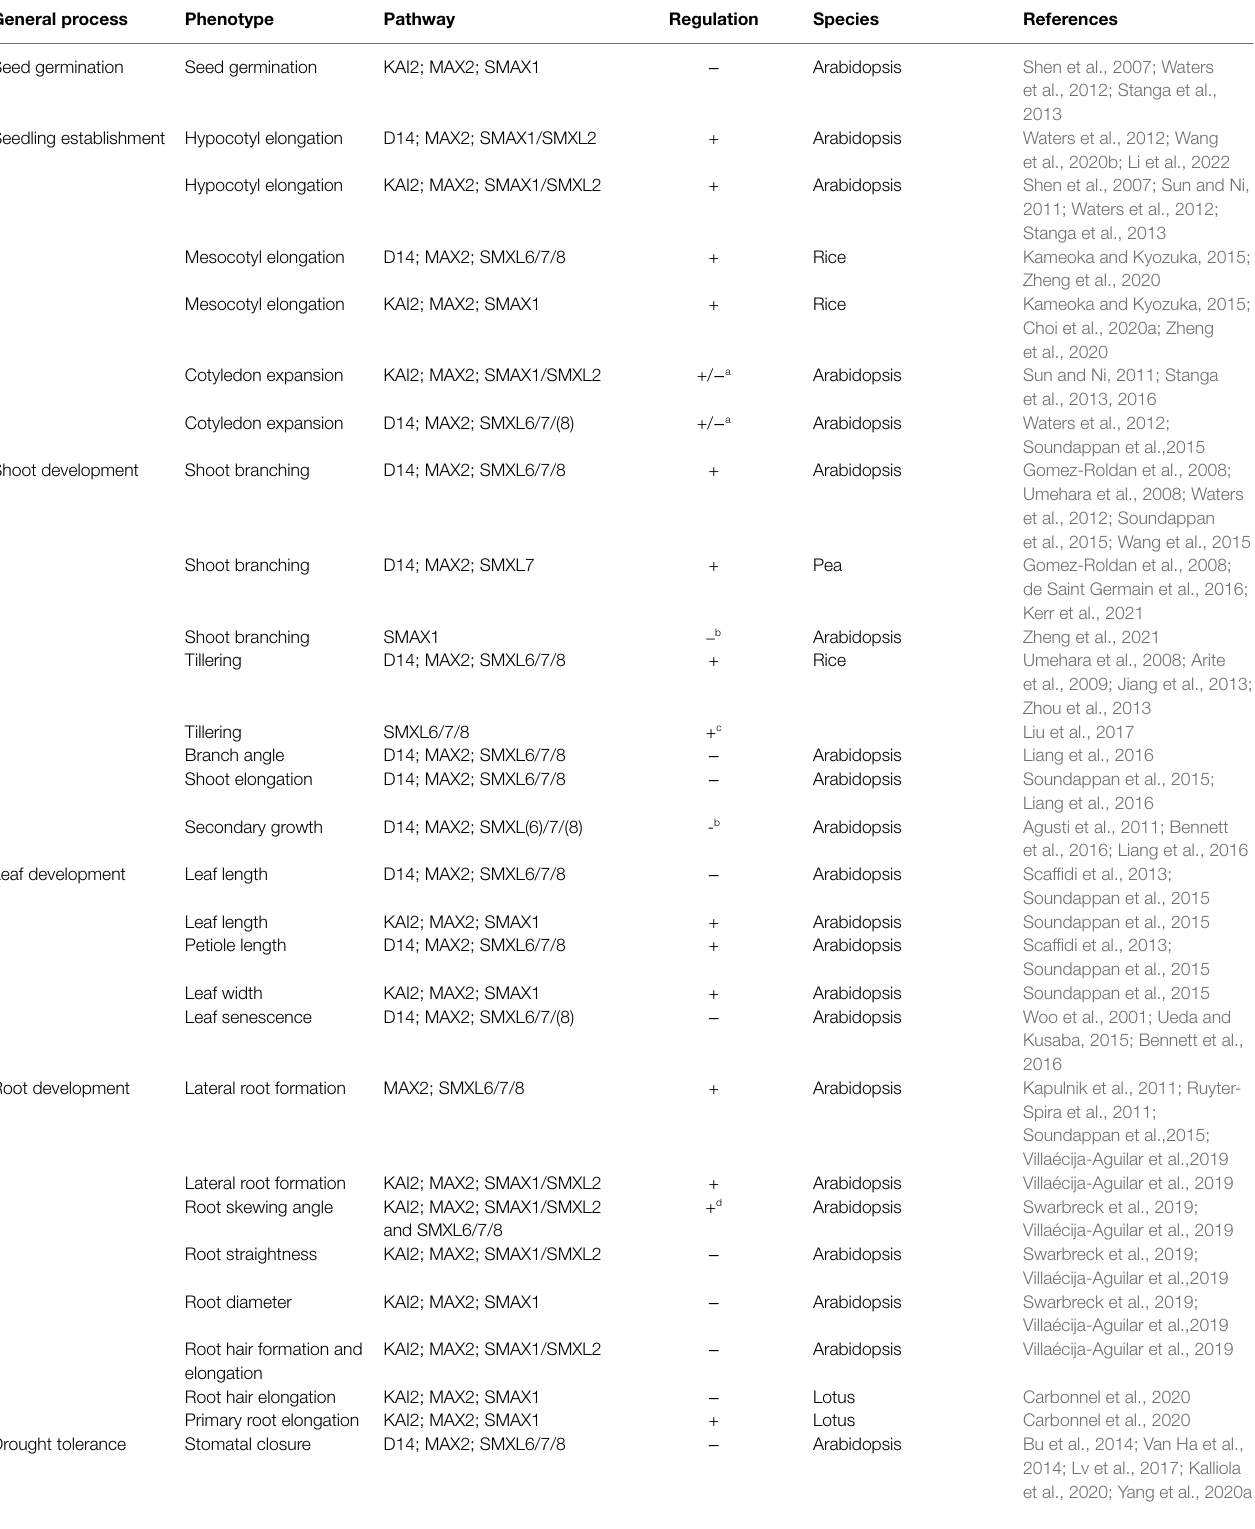
TABLE 1 | Physiological functions of SMXL proteins with the corresponding core signaling pathways and the manner (positive or negative), in which the phenotype is regulated by the SMXLs. General